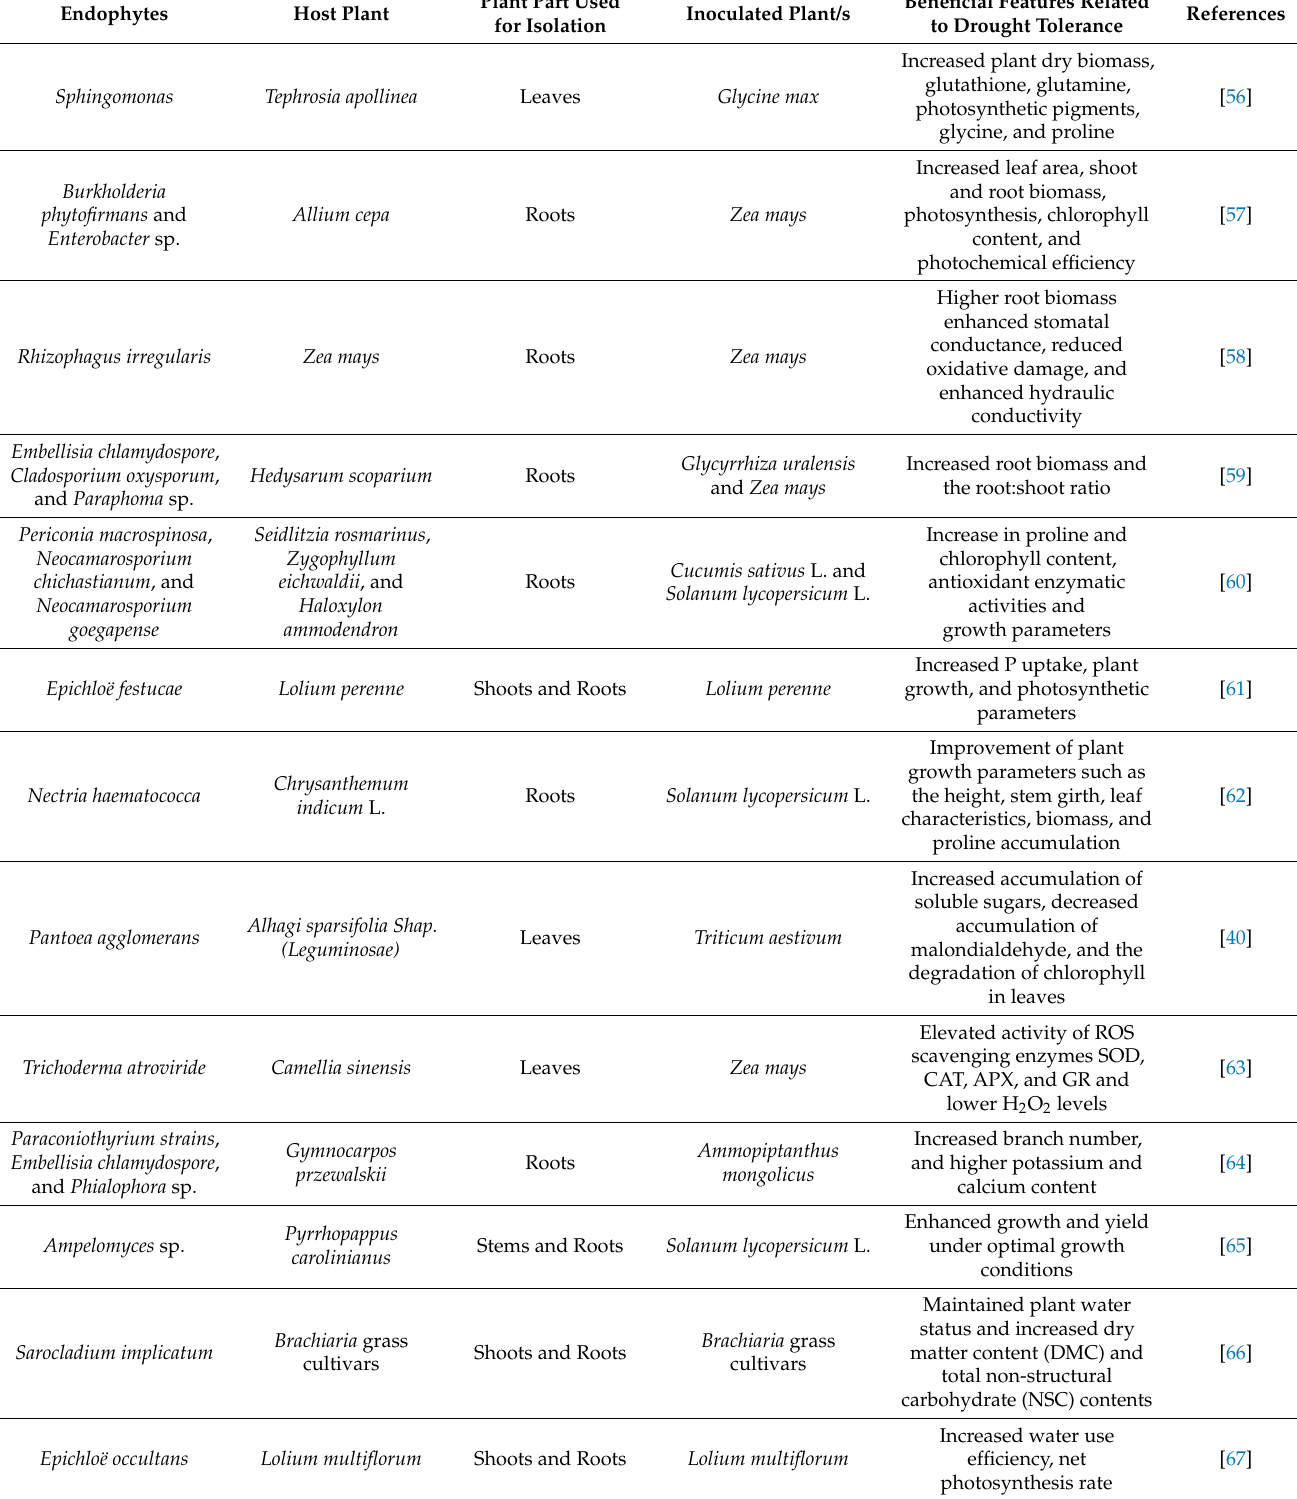
Table 1. Endophyte-assisted drought tolerance in